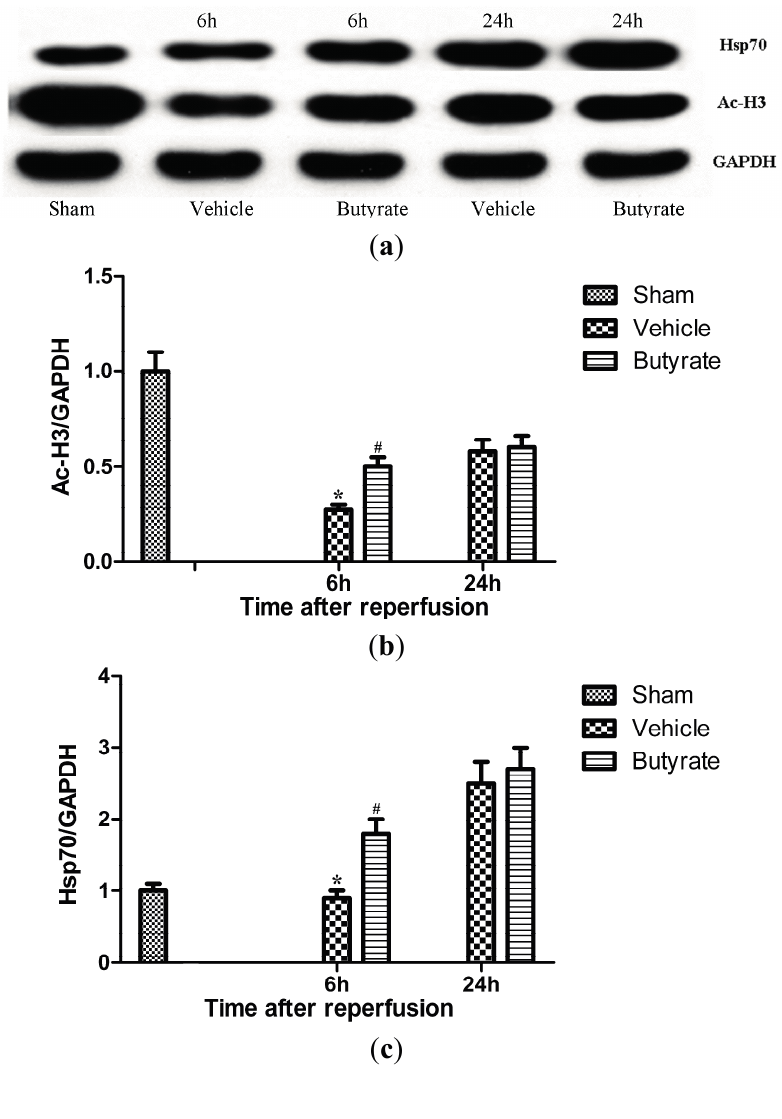
Figure 4. Western blot analysis of Ac-H3 and Hsp70 in liver tissue at 6 and 24 h after reperfusion. Ac-H3 and Hsp70 expression levels were measured by densitometric analysis. GAPDH expression was used as a loading control. ( a ) Blot shown is representative of three experiments with similar results; The expression of Ac-H3 ( b ) and Hsp70 ( c ) was significantly decreased in the vehicle group, which was markedly increased by butyrate administration. Data represent means ± SD, n = 4–5 rats per group. * p < 0.05 vs. the sham group, # p < 0.05 vs. the vehicle